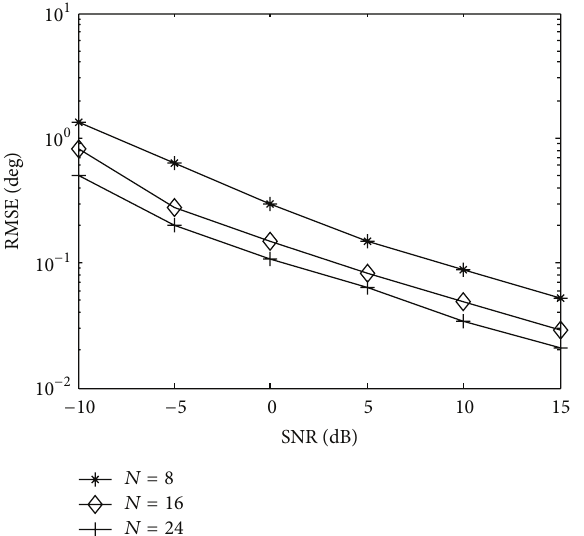
Figure 8: Angle estimation performance of our algorithm with different 𝑁 ( 𝑀 = 16 , 𝐿 = 100 , and 𝐾 = 3 ).